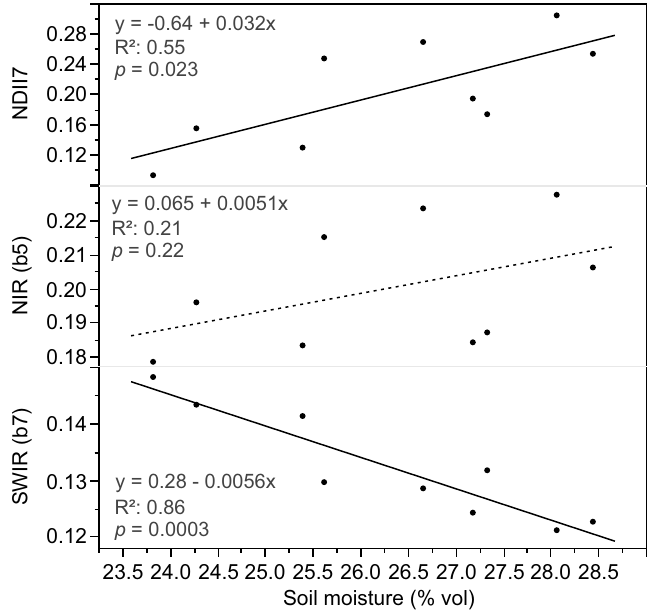
Figure 6. Relationships of NDII7, NIR, and SWIR reflectance (Landsat 8 OLI) with percent soil moisture (7 cm depth) at a field monitoring site in a severe burn. Each data point is from a different day in the 2014–2015 snow-free seasons ( n = 9). Solid lines depict significant regressions; dashed lines depict insignificant